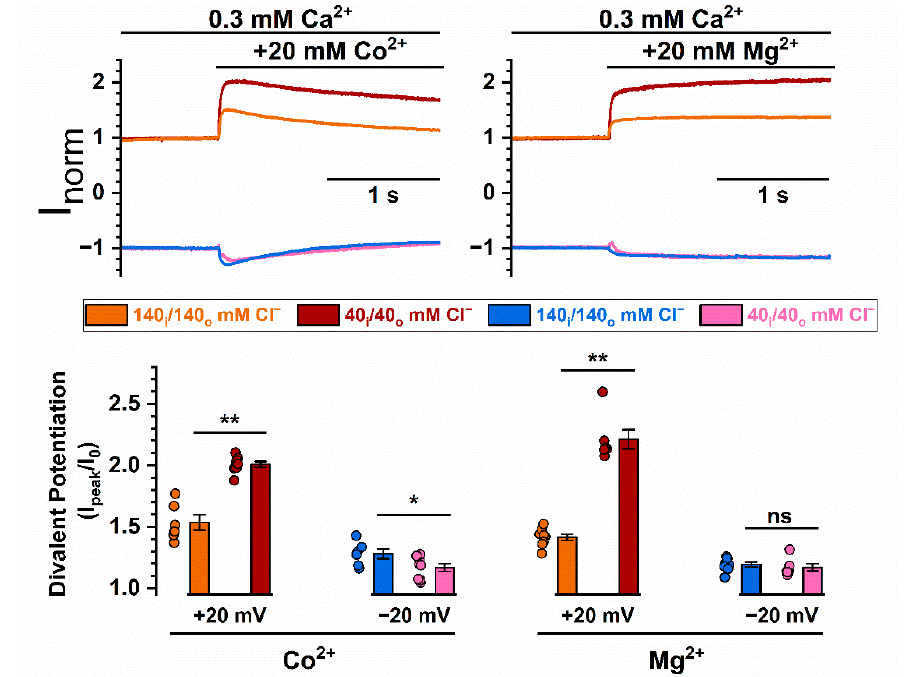
Figure 5. Enhanced divalent cation potentiation of WT 16A in low ionic strength solutions. (Top) Recording traces comparing the Co 2+ or Mg 2+ potentiation of WT 16A between conditions of symmetrical 140 mM and 40 mM NaCl. The 40 mM NaCl solution also contains 100 mM D-mannitol. All currents were induced by 0.3 mM [Ca 2+ ] i . (Bottom) Bar graph summarizing Co 2+ and Mg 2+ potentiation under symmetrical 140 mM or 40 mM NaCl ( n = 6–8). ns p > 0.05; * p < 0.05; ** p < 0.005 by one-way ANOVA followed by Bonferroni’s multiple comparisons.